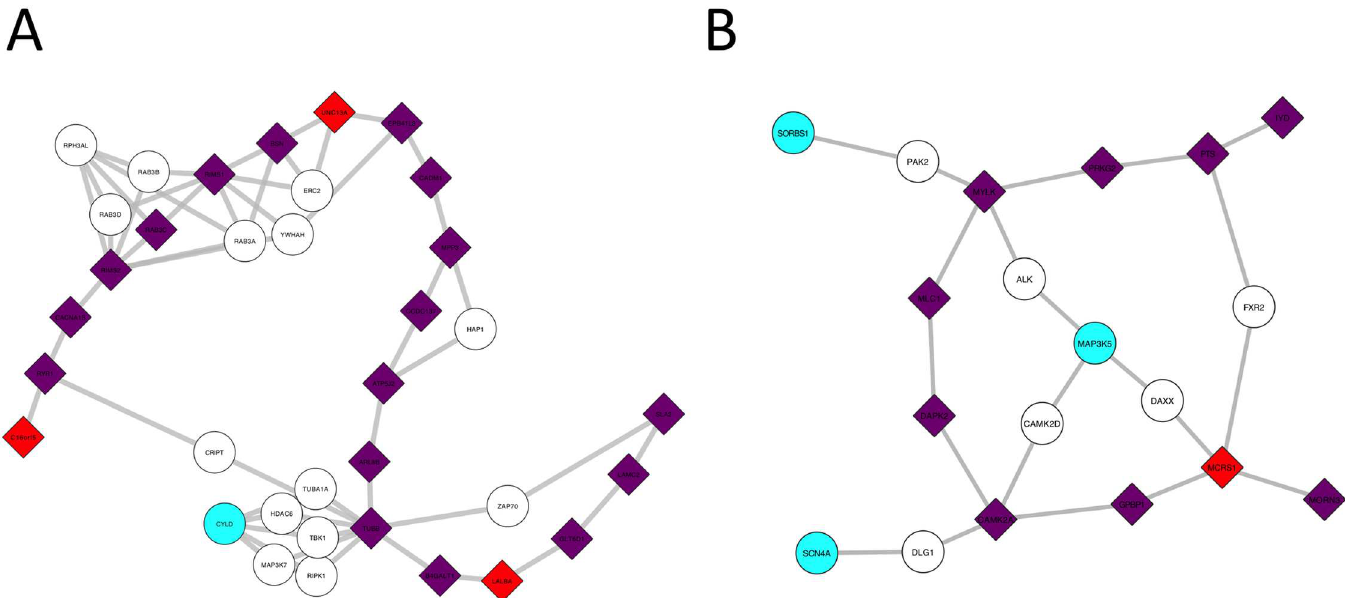
Fig 4. Results of Hotnet2 and Conflux on two radomly generated chain-shaped disease subnetworks. (A) Chainof 20 causal genes. (B) Chainof 10 causal genes. The nodes in purpleare genes found by both Hotnet2 and Conflux. The nodesin cyan were only found by Hotnet2. The nodesin red and pink are respectivelynodesdetected (marginal (cid:21) 0.2) or havingsuggestiveevidence(marginal (cid:21) 0.05) by Conflux. Nodes coloredin plum were found by Hotnet2 but only have suggestiveevidencein Conflux. The diamondshapednodes are the true causal genes. The sample size used is n = 800.